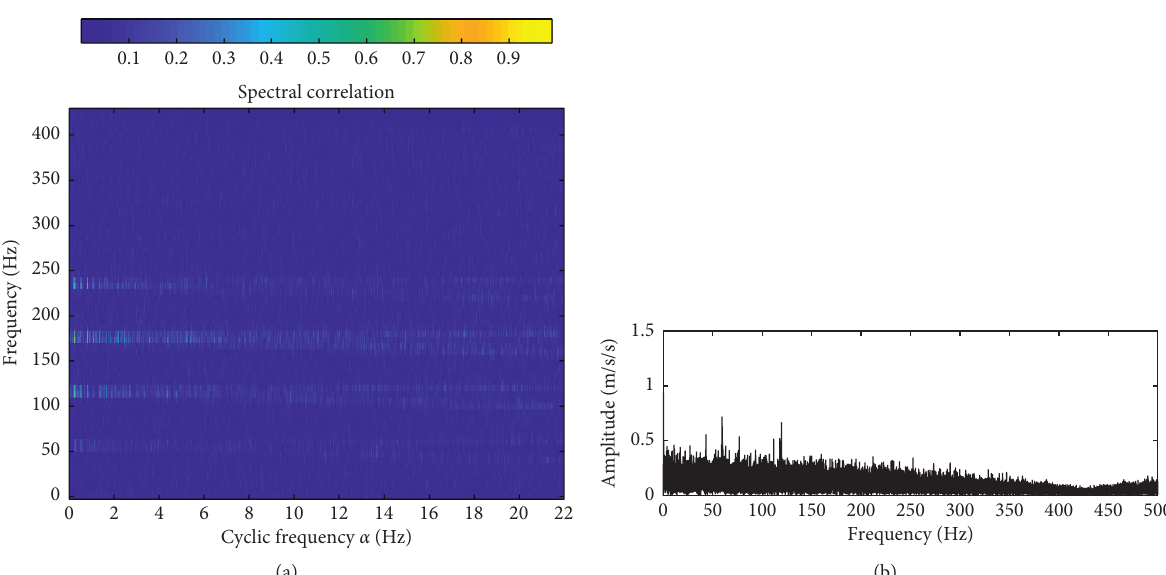
Figure 12: FSC image and EES of the signal as shown in Figure 12(a): (a) FSC image of the signal as shown in Figure 11(a); (b) EES of the signal as shown in Figure 12(a) by using the obtained FSC image as shown in Figure 12(a).